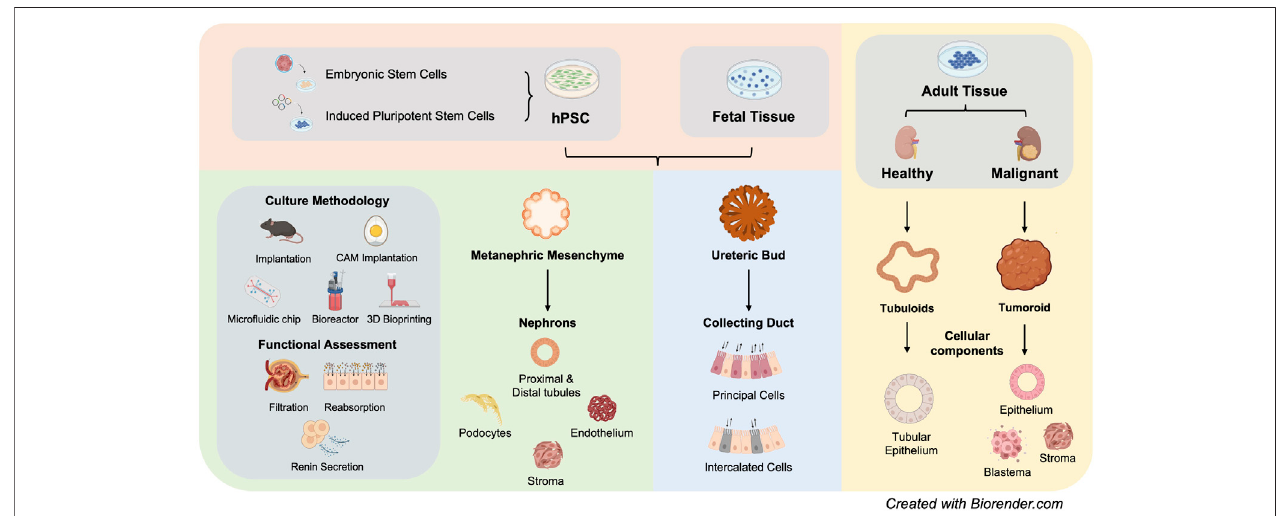
FIGURE 1 | Summary of current kideny organoid models (hPSC: human pluripotent stem cells).